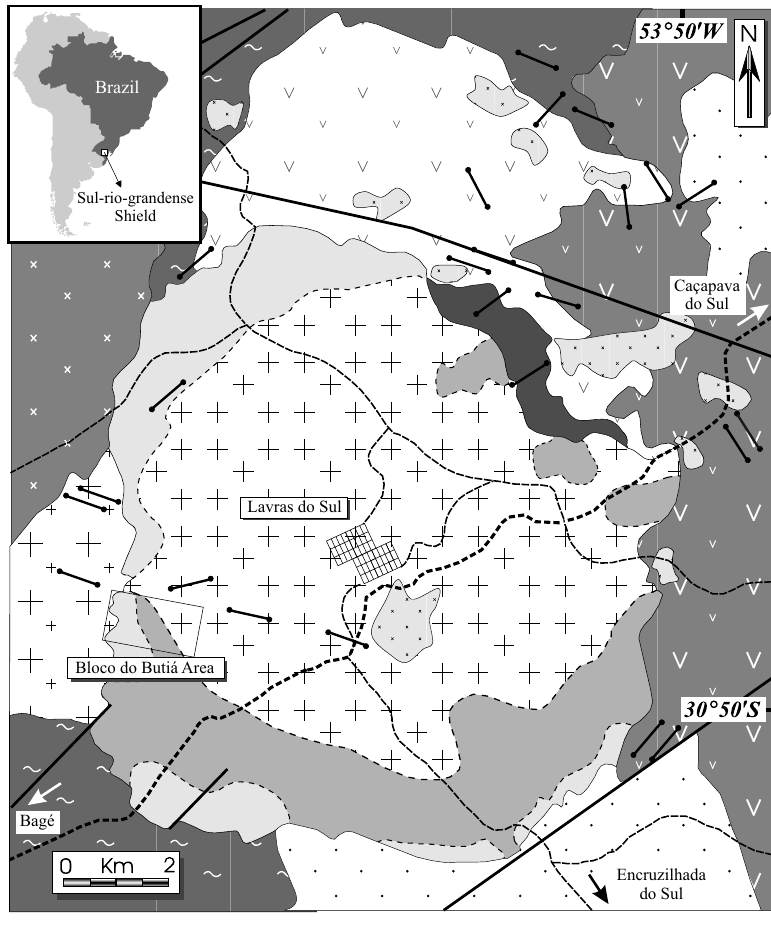
Fig. 1 – Location and geological map of the studied area. Adapted from Gastal and Lafon (1998).